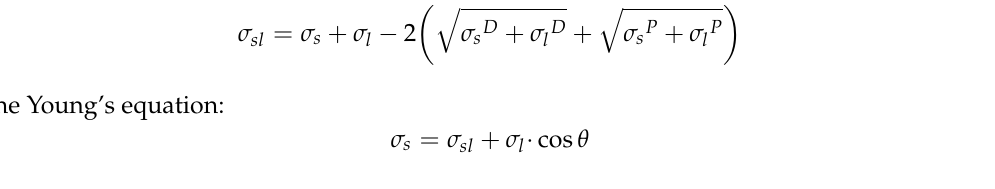
Table 3. Values of the surface tension and its components of the liquids used for contact angle measurements